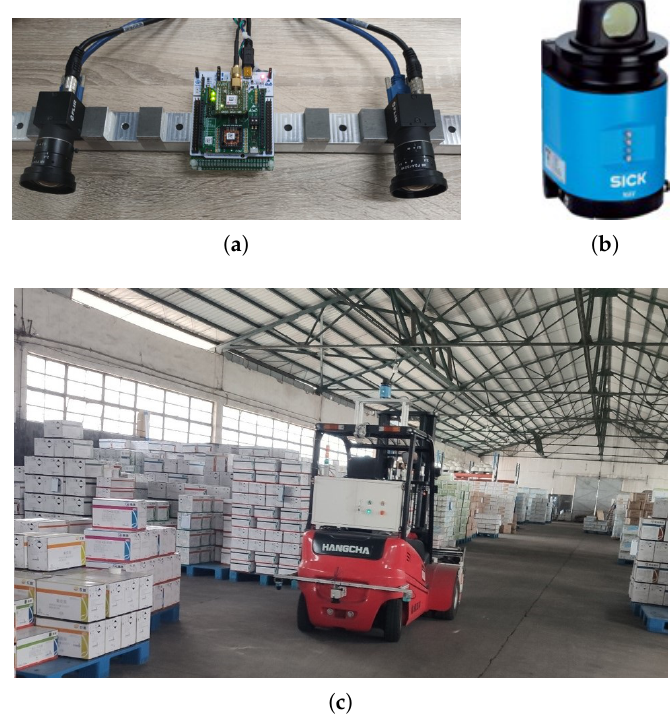
Figure 4. Dataset collection platform that includes the stereo camera, NAV350 laser sensor, artificial reflective landmark, and automatic guided forklift. ( a ) Stereo camera. Two monocular cameras triggered by the same signal source were used to capture pictures of the warehouse. ( b ) SICK NAV350. The NAV350 sensor was used to measure the global position of the forklift in the warehouse. ( c ) The forklift running in the warehouse.